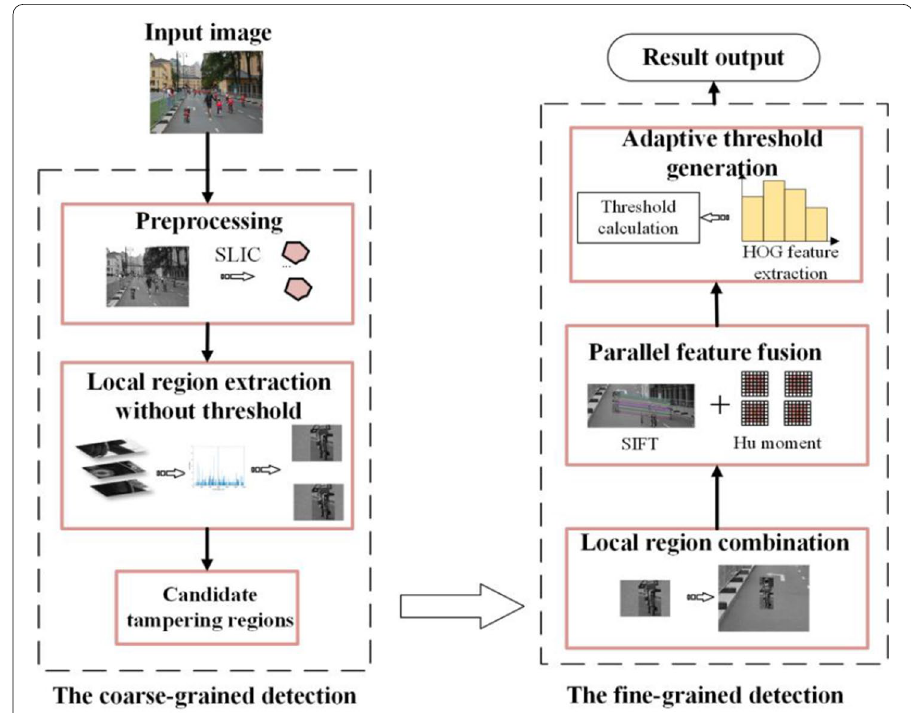
Fig. 1 The proposed method